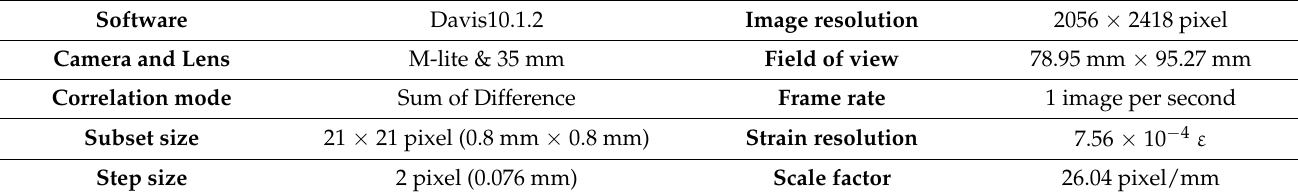
Table 3. DIC technique parameters.